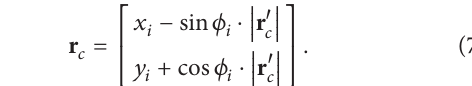
Figure 6: The finite element analysis model of the